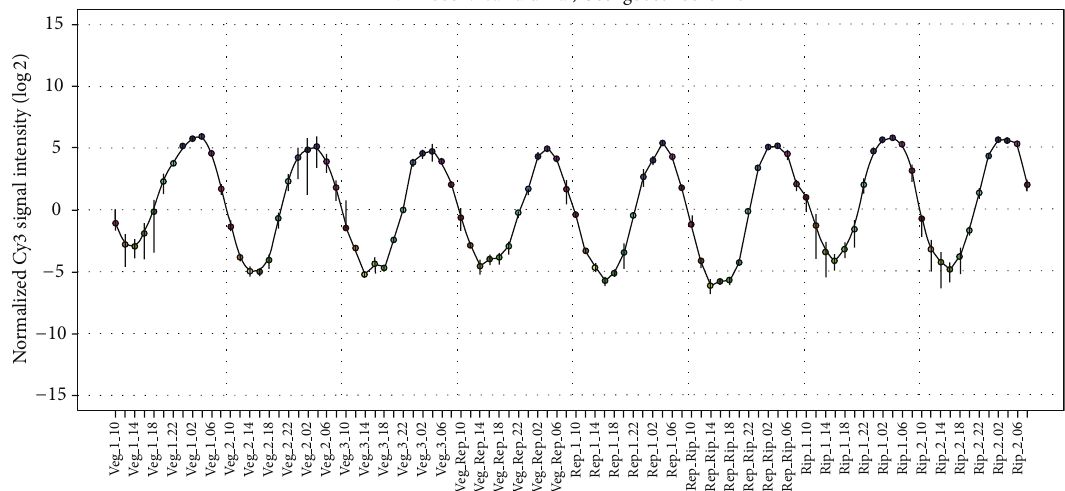
Figure 4: Expression of CMYB1 in rice response to circadian rhythm in leaves under different developmental stages. Veg.: vegetative; Rep.: reproductive; Rip.: ripening. The gene expression analysis is based on RiceXPro microarray data [24].